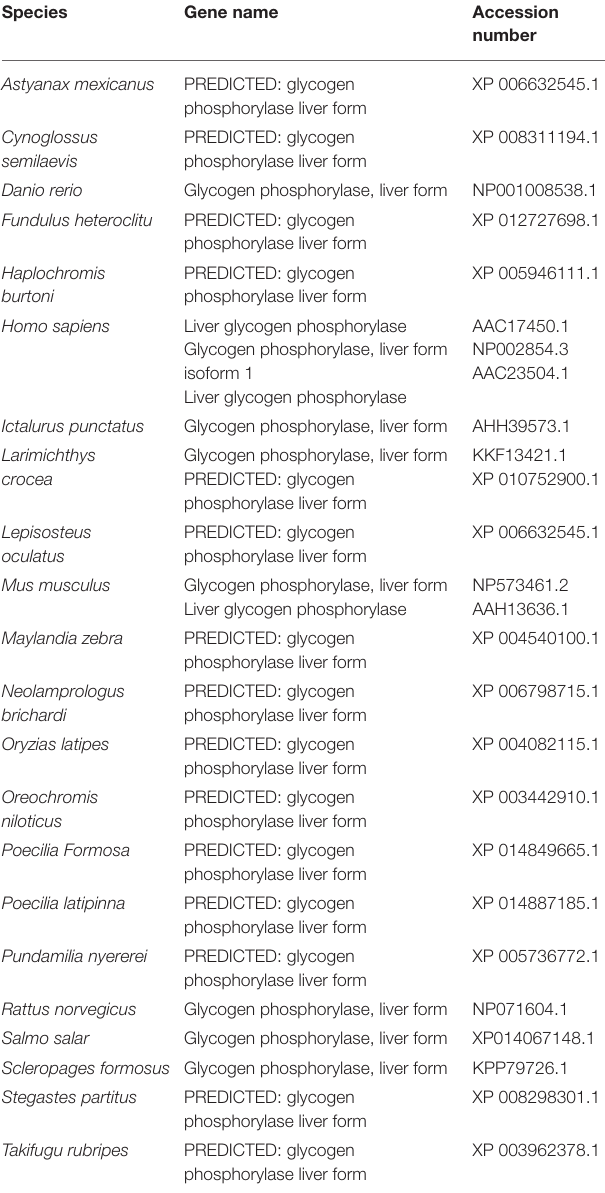
TABLE 1 | Reference proteins from NCBI database for Pygl phylogenetic